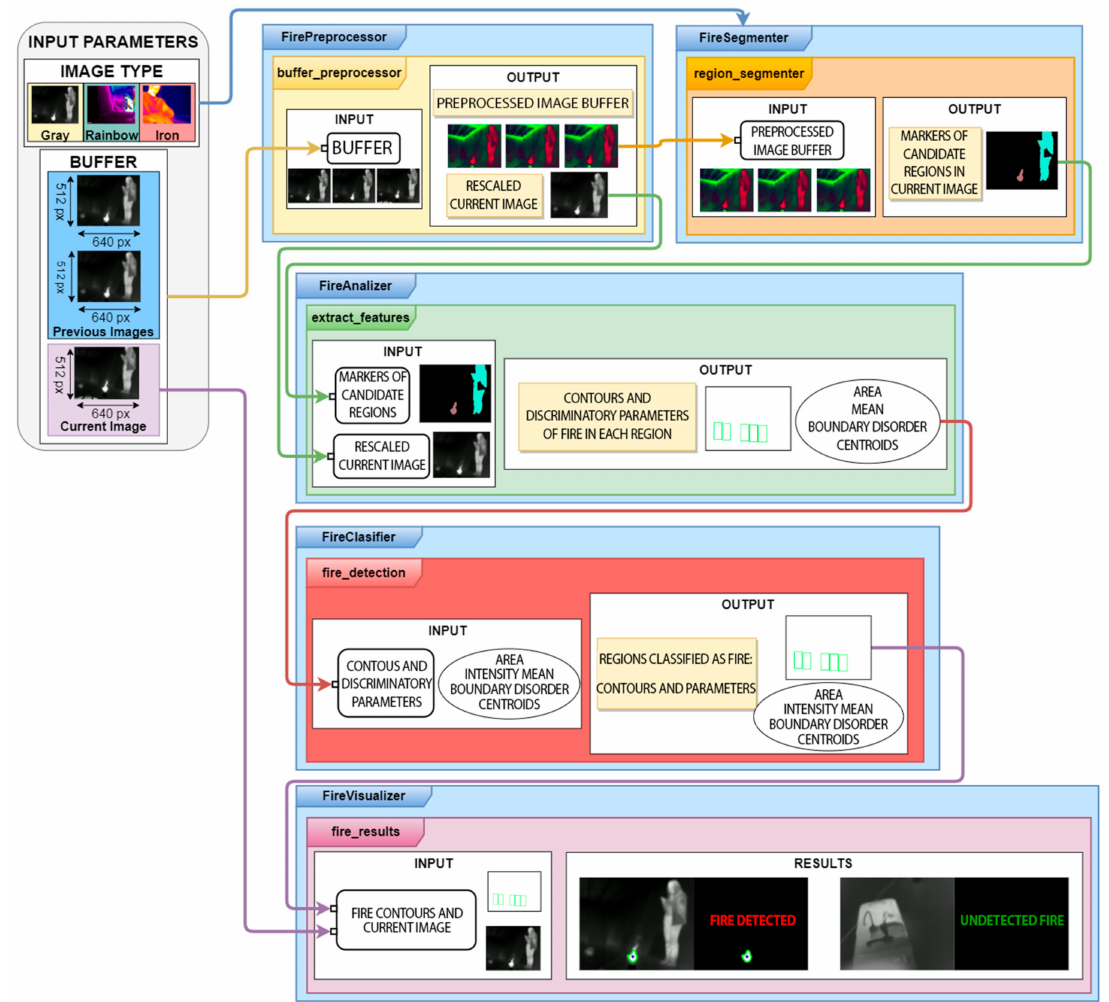
Figure 3. Fire detection algorithm